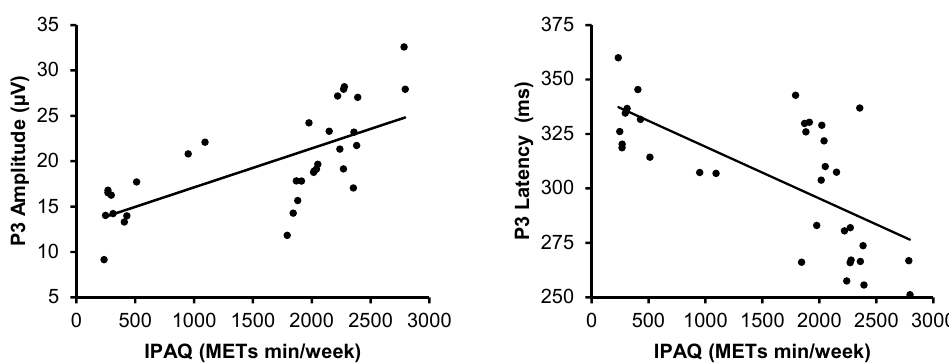
Figure 4. Scattergrams and correlation coefficients of P3 amplitude (left) and latency (right) from the averaged Fz, Cz, and Pz sites with the amount of physical activity calculated by the metabolic equivalent of task (METs min/week).